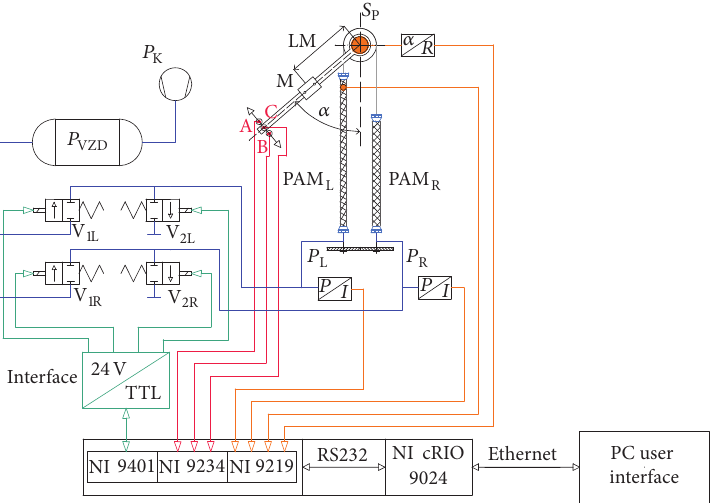
Figure 3: Schematic representation of the experimental involvement. PAM L : left pneumatic artificial muscle, PAM R : right pneumatic artificial muscle, LM: distance of a gravity center of an onerous element M from the pivoting arm shaft, 𝑃 R : right pressure sensor, 𝑃 : pressure, 𝑆 P : potentiometric position sensor, 𝛼 : rotation angle of the arm from the neutral position, 𝑃 L : left pressure sensor, 𝑃 R : right pressure sensor, 𝐼 : electric current, 𝑅 : electrical resistance, 𝑃 K : pressure at the compressor outlet, V 1 L / V 1 R : left/right inflation electropneumatic valve, V 2 L / V 2 R : left/right draining electropneumatic valve, 𝑃 VZD : pressure in the air tank pressure, and A/B/C: acceleration sensors. Orange colour: signals from measuring devices, red colour: signals from vibration sensors, green colour: control signals to control electropneumatic valves, and blue colour: transport routes for pressure medium.